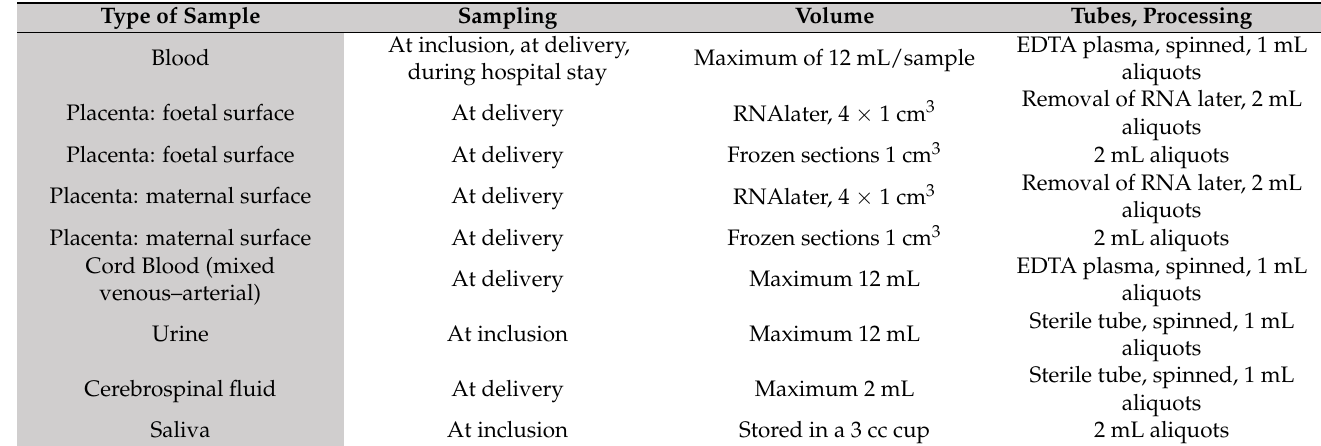
Table 2. Biological samples collected for the PROVE